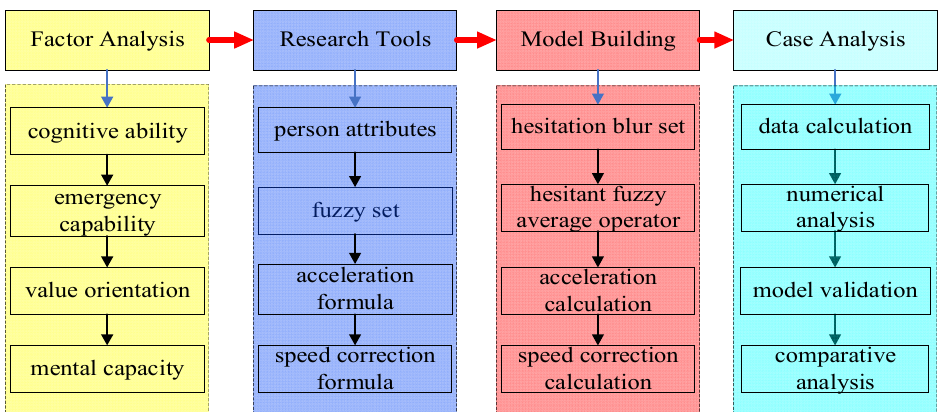
Figure 1. Research process.